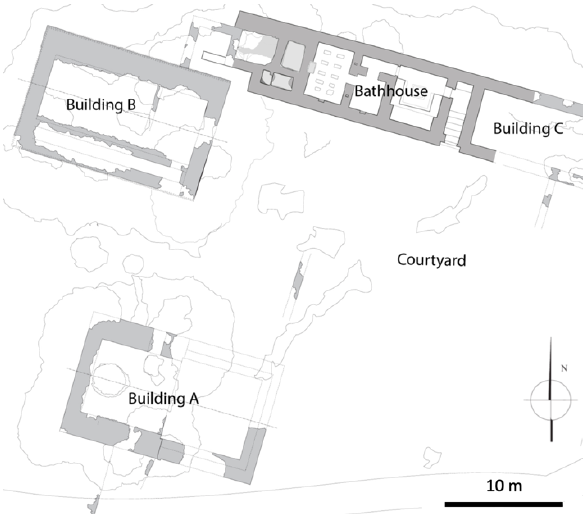
Figure 2: Building A, B and C, Khirbat al-D ū saq, general plan of the site (2017 ©Mission Kh. Al-Dusaq, / survey and drawing Ch. March 2008-2009 & R. Elter 2014,